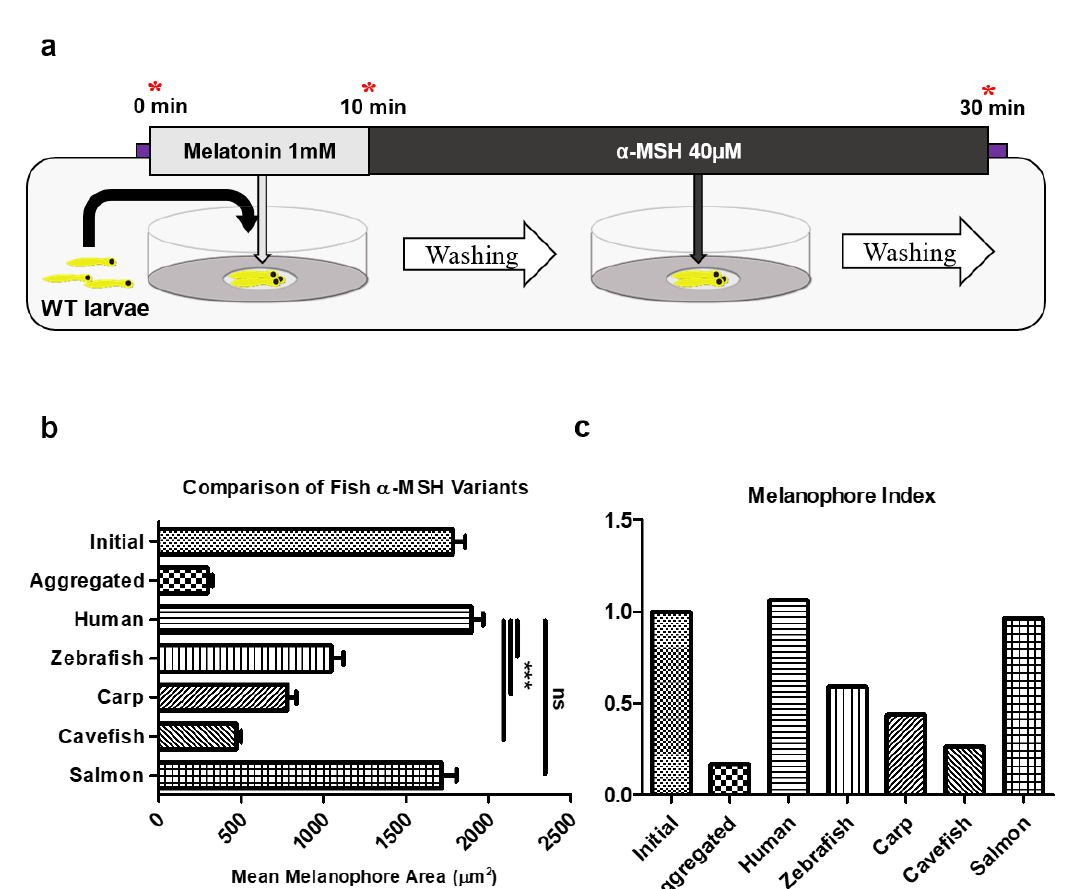
Figure 4. Melanophore dish assay comparing α -MSH variants from different species. ( a ) Schematic of melanophore dish assay with wild-type (WT) larvae. Red asterisks indicate imaging timepoints. ( b ) Results of melanophore dish assay comparing mean melanophore area ( n = 30 – 50 melanophores from 3 – 5 larvae) calculated after induction of melanosome dispersion by treatment of the respective α -MSH peptide. One-way ANOVA with post-hoc Dunn’s multiple comparison test was used for statistical significance between groups; data represented as mean ± SEM; *** p < 0.001, ns = not significant. ( c ) Normalization of mean melanophore area by initial area of the control group (see Equation (1)).